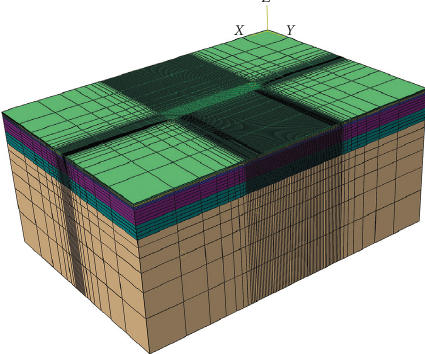
Figure 5: Mesh of the 3D FE model.